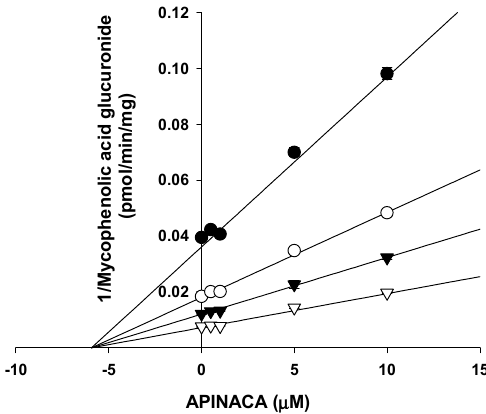
Figure 5. Representative Dixon plot for the inhibitory effect of APINACA on UGT1A9-catalyzed mycophenolic acid glucuronidation in ultrapooled human liver microsomes. Each symbol represents the concentration of mycophenolic acid: • , 0.2 µ M; , 0.4 µ M; (cid:72) , 0.6 µ M; (cid:53) , 1 µ M. The data are the means ± SD ( n = 3).